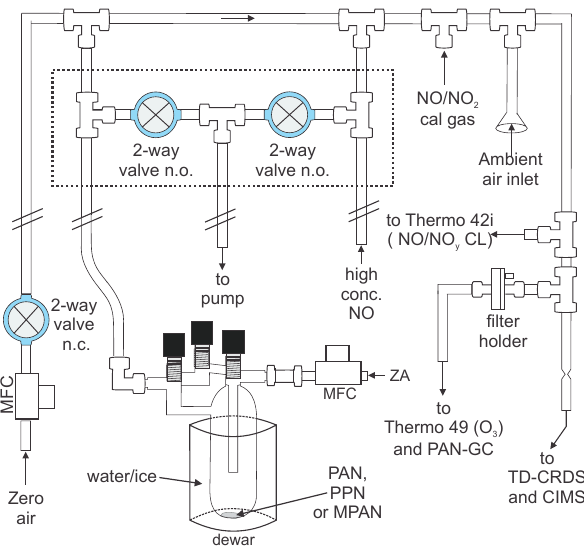
Figure 3. Schematic of the inlet and calibration setup used during the Abbotsford 2012 and FOSSILS 2013 field cam- paigns. MFC = mass flow controller, CL = chemiluminescence, n.o. = normally open, n.c. = normally closed.